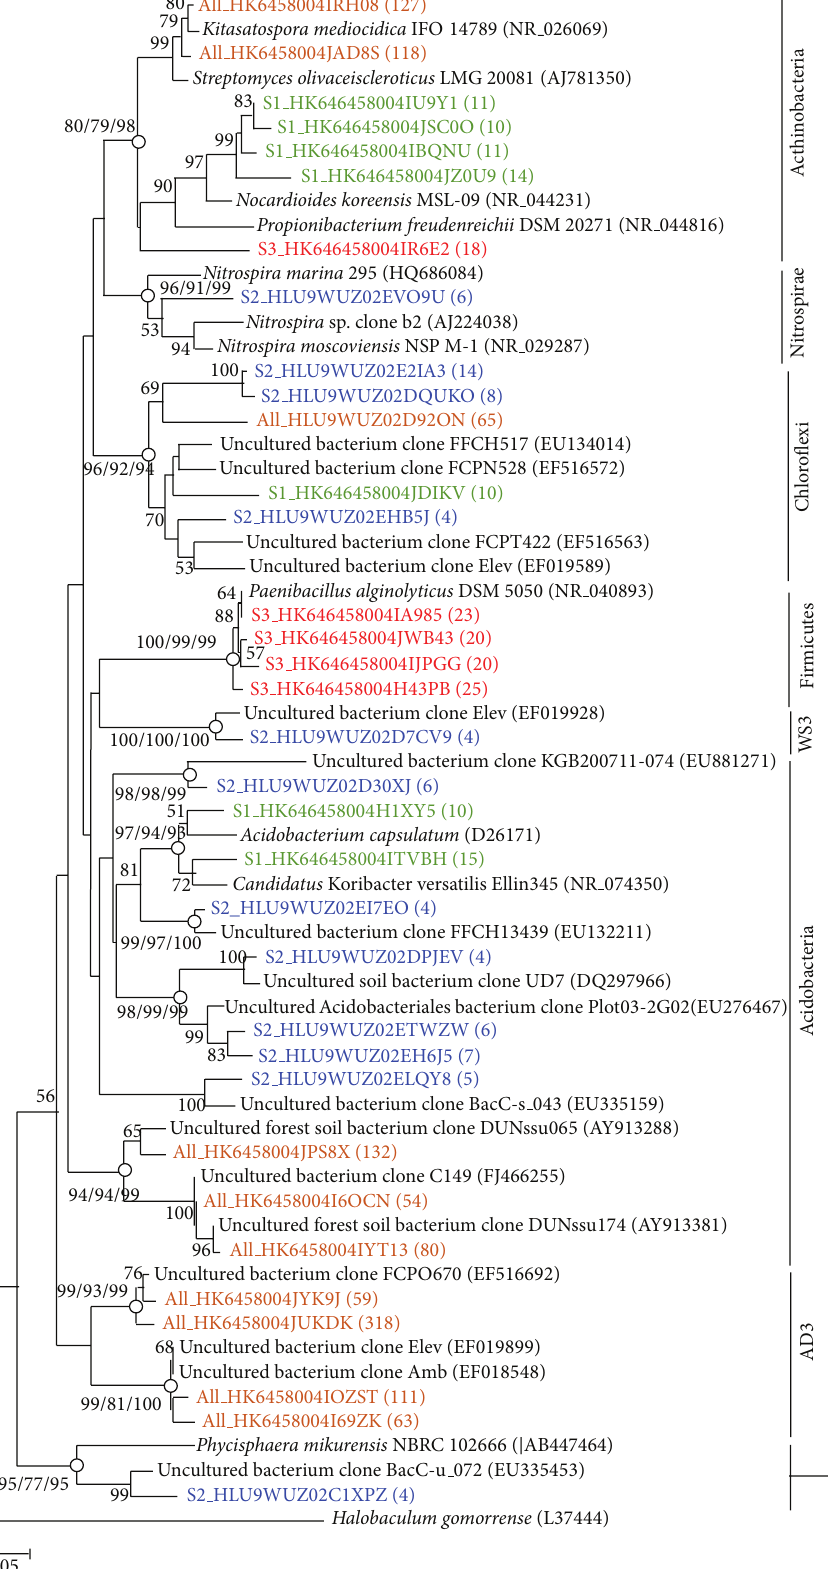
Figure 8: Neighbor-joining phylogenetic tree showing the dominant bacterial relationships associated with phyla other than Proteobacteria in the soil samples. The bar in the bottom represents 0.05 nucleotide substitutions per nucleotide